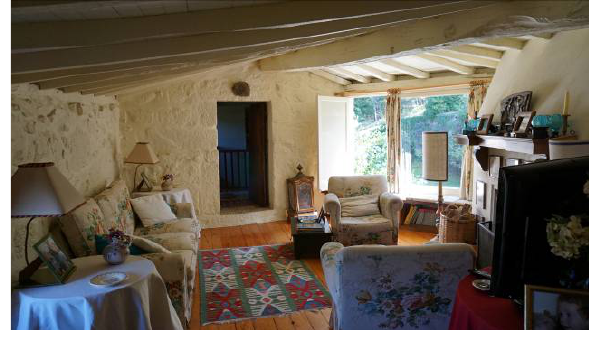
Figure 5. Sitting